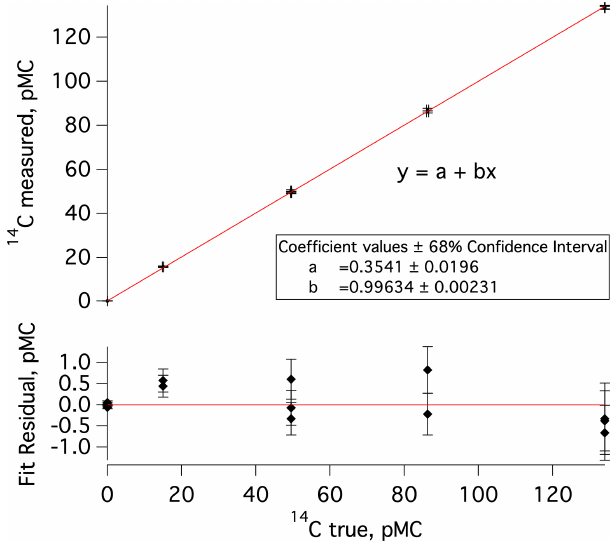
Figure 2. Top: a plot of measured versus true (accepted) 14 C values for commensurately sized 14 C standards and blanks that were pro- cessed at ANSTO concurrently with the second set of MLO 14 CO samples and blanks (samples 7–18 in Table S1 and blanks 3–6 in Ta- ble S2). The data point clusters, going from left to right, represent a previously characterized cylinder of 14 C-depleted CO 2 ( 14 C true = 0 . 03pMC), IAEA-C8 ( 14 C true = 15 . 03 ± 0 . 17pMC; Le Clercq et al., 1998), IAEA-C7 ( 14 C true = 49 . 53 ± 0 . 12pMC; Le Clercq et al., 1998), a second previously characterized cylinder of CO 2 ( 14 C true = 86 . 27pMC), and HOxII ( 14 C true = 134 . 06 ± 0 . 04pMC; Wacker et al., 2019, and references therein). Bottom: residuals from the linear fit in the upper plot; error bars represent uncertainty in 14 C